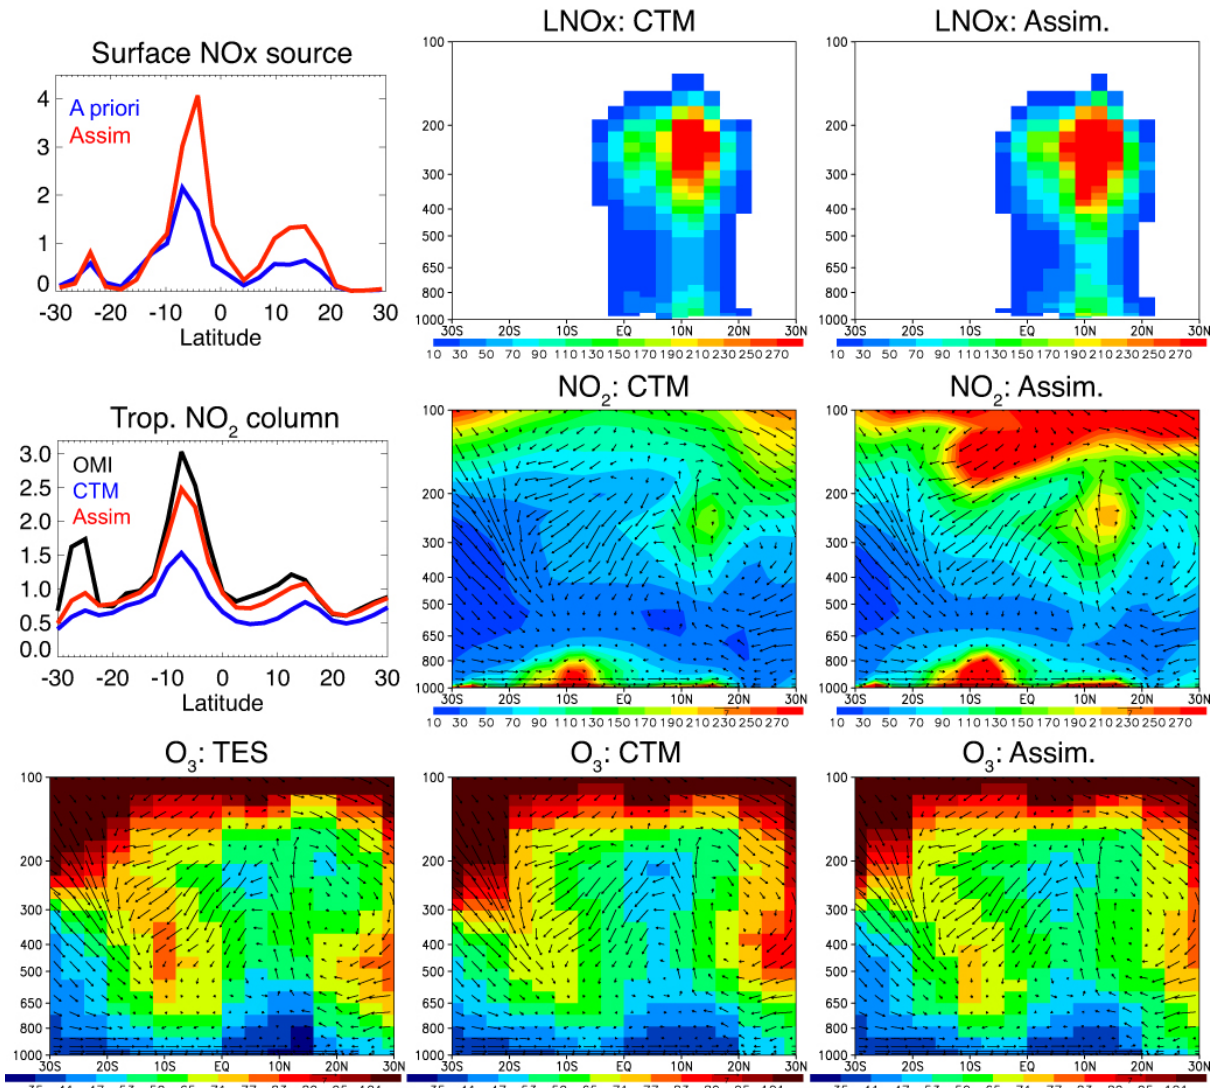
Fig. 12. Latitude-pressure cross-section of the longitudinal-mean (6 ◦ W–30 ◦ E) of the LNO x source (upper, in pptvday − 1 ), NO 2 concentra- tion (middle, in pptv), and O 3 concentration (lower, ppbv) over Africa. The results obtained from the CTM simulation (center) and analyzed from the data assimilation (right) are presented. The lower left panel shows the result obtained from the TES measurement for O 3 concentra- tion. Also shown are the latitudinal distributions of (upper left panel) the longitudinal-mean surface emissions of NO x (in 10 − 11 kgm − 2 s − 1 ) as obtained from the a priori emissions constructed based on the EDGAR 4.2, the GFED 3.1, and the GEIA inventories (see text in Sect. 3.1.1) (blue line) and analyzed from the data assimilation (red line) and (center left panel) the longitudinal-mean tropospheric NO 2 columns (in 10 15 moleccm − 2 ) as obtained from the OMI measurements (black line), the CTM simulation (blue line), and analyzed from the data assimilation (red line). The vectors represent meridional-vertical winds. Each is averaged over 10–20 July